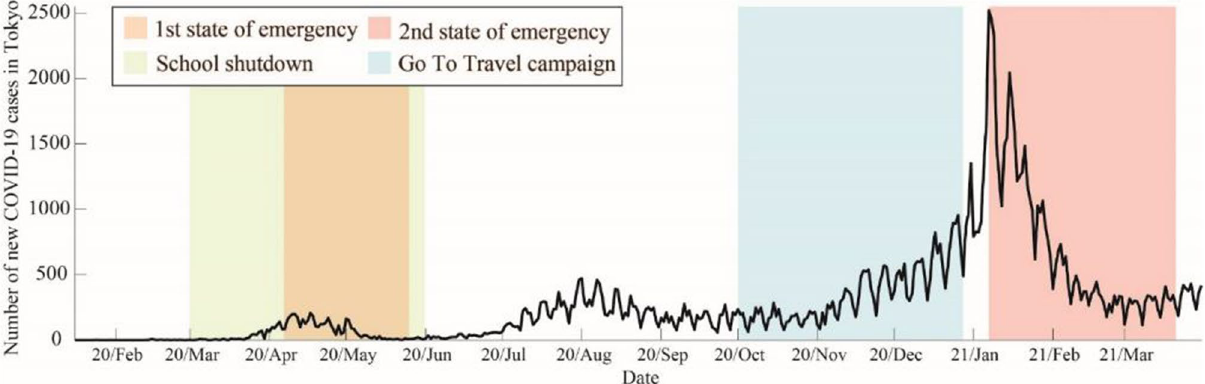
Figure 1. Number of new COVID-19 cases in Tokyo. The black solid line indicates the number of new COVID- 19 cases in Tokyo; the orange and pink shaded areas represent the periods of the first and second states of emergency states in Tokyo, respectively; the green shaded area represents the period of school closures; and the light blue shaded area represents the period of the Go To Travel